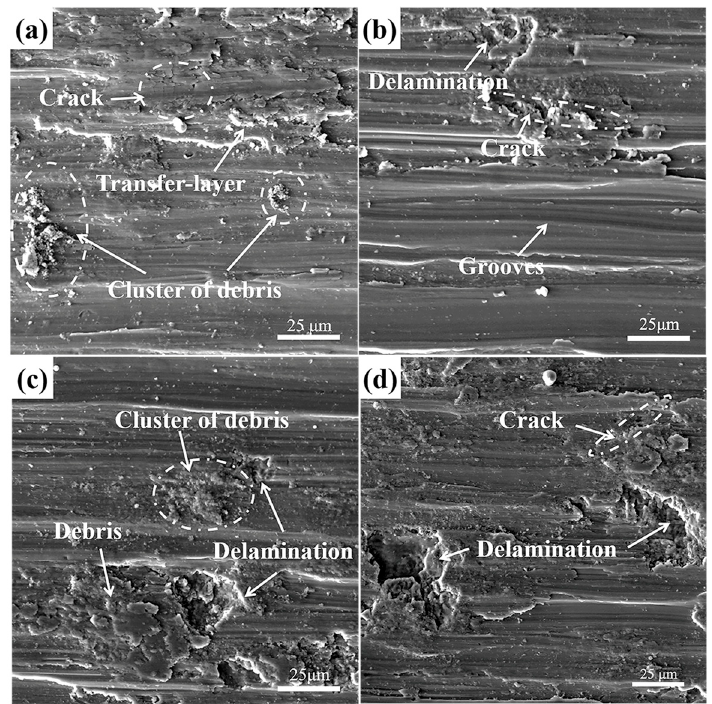
Figure 8. SEM images showing typical tribological features of polished Ti-6Al-4V alloy after different sliding time: ( a ) 3; ( b ) 6; ( c ) 9 and ( d ) 15